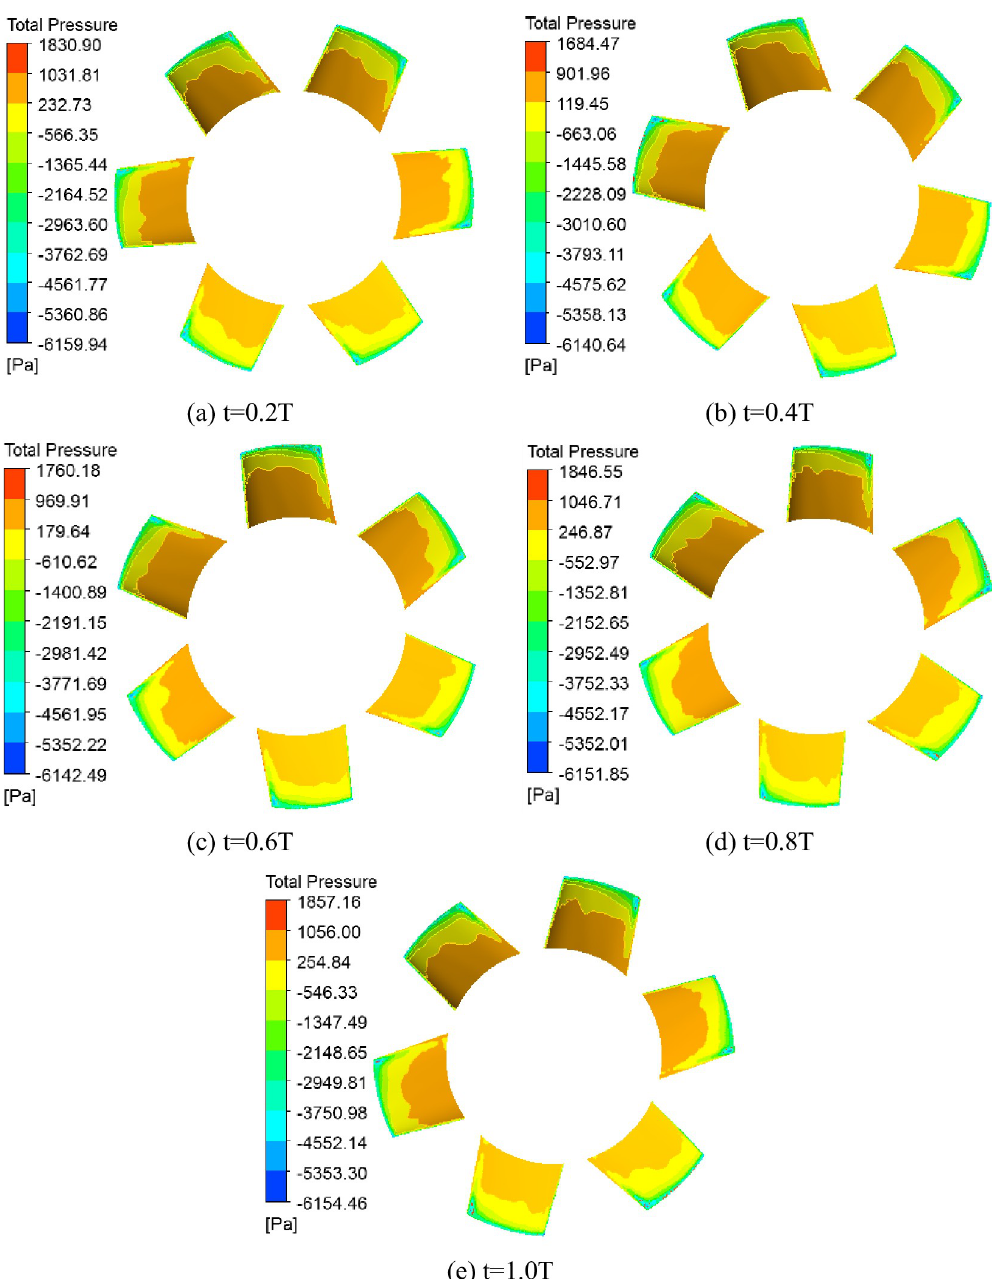
Fig 5. Total pressure distribution of second-stage blade suction surface under F =